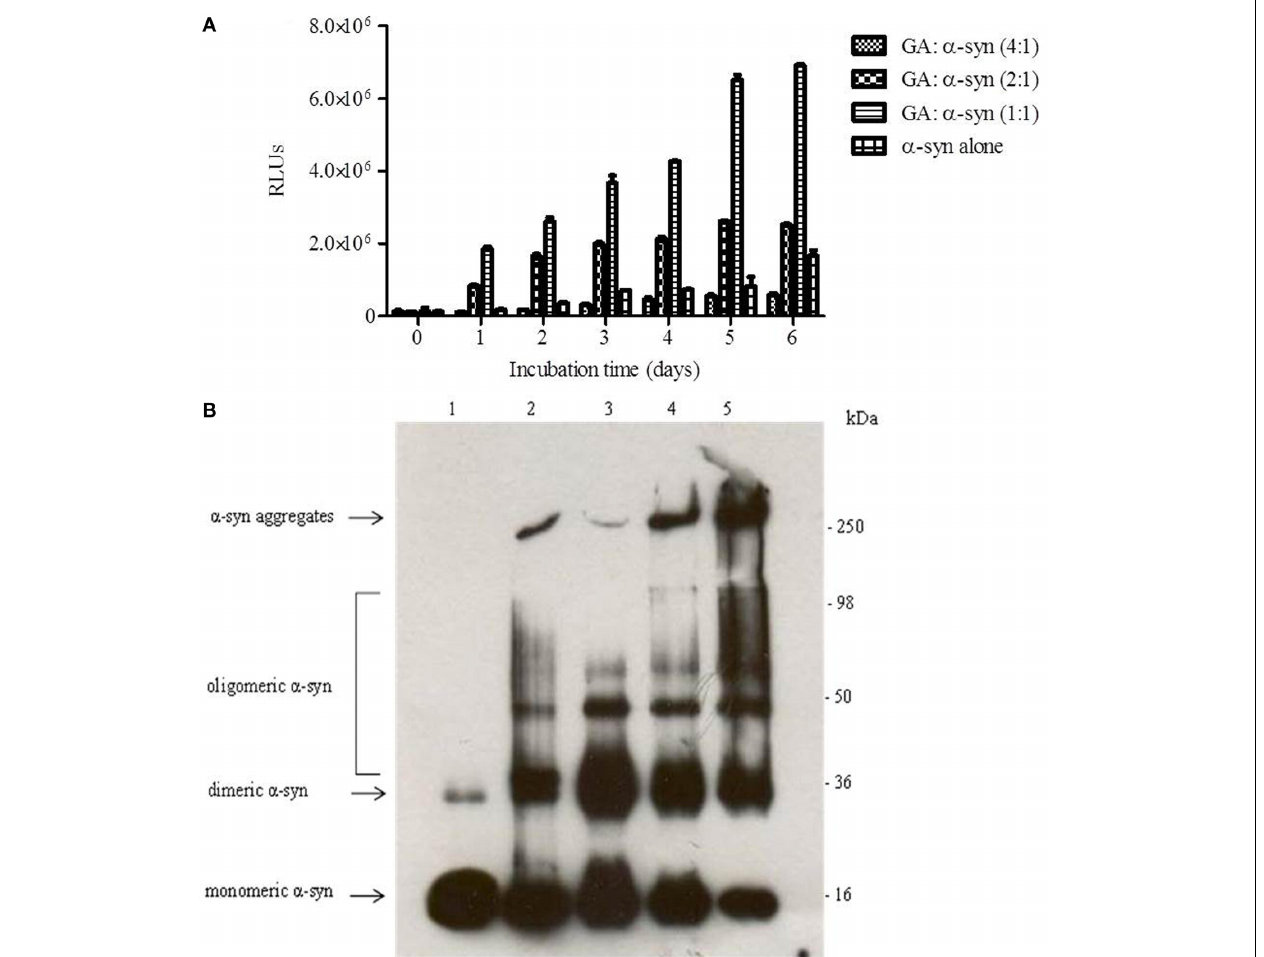
FIGURE 2 | GA inhibits α -syn oligomerization at a high concentration, but at lower concentrations it promotes oligomerization. (A) Samples of α -syn (25 μ M) aged alone or in the presence of GA at different molar ratios for 6 days with continuous shaking at 37 ◦ C were assessed for their ability to inhibit the formation of oligomers by the oligomeric ELISA assay. The assay was performed in duplicate (average of duplicate measurements ± standard